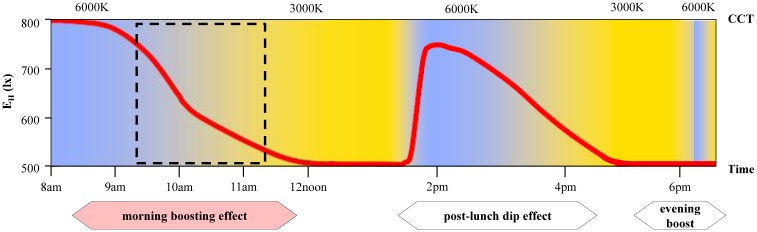
The human rhythmic dynamic lighting protocol.Red solid line represents gradual changes of illuminance levels, Blue shaded area represents CCT 6000 K, Yellow shaded area 3000 K, Black dotted line focuses on the recommended luminous conditions for boosting effect during the peak morning work period. (With permission from [12]).